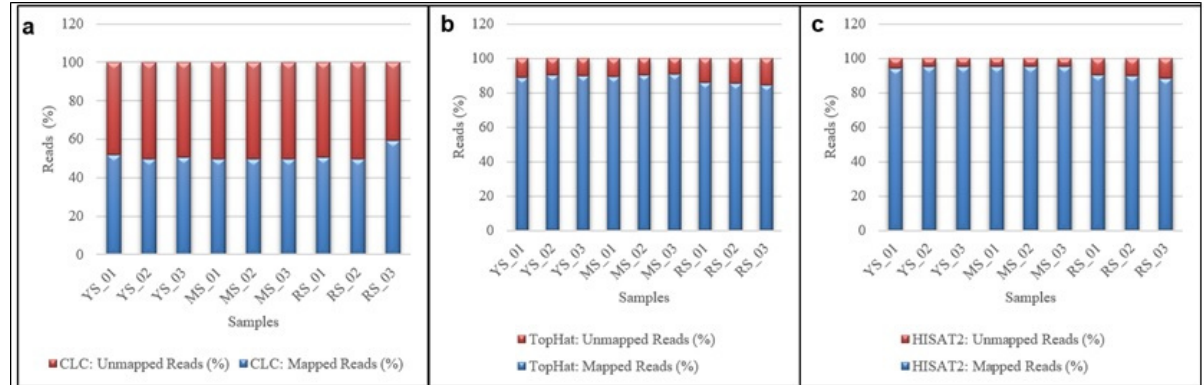
Figure 2 − Comparison of the percentage of mapped and unmapped reads using CLC Mapping, TopHat, and HISAT2. (a) CLC Mapping, (b) TopHat Mapping, and (c) HISAT.